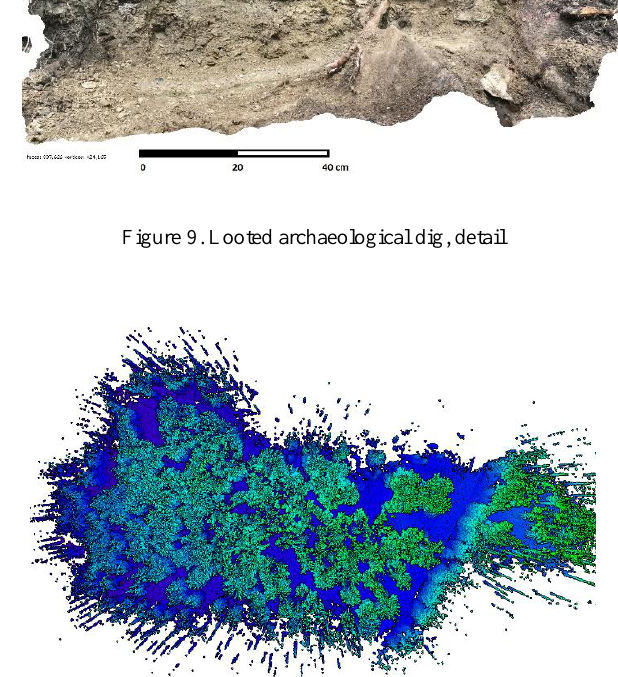
Figure 10. The measurement was made using the ZEB-REVO personal mobile laser scanner